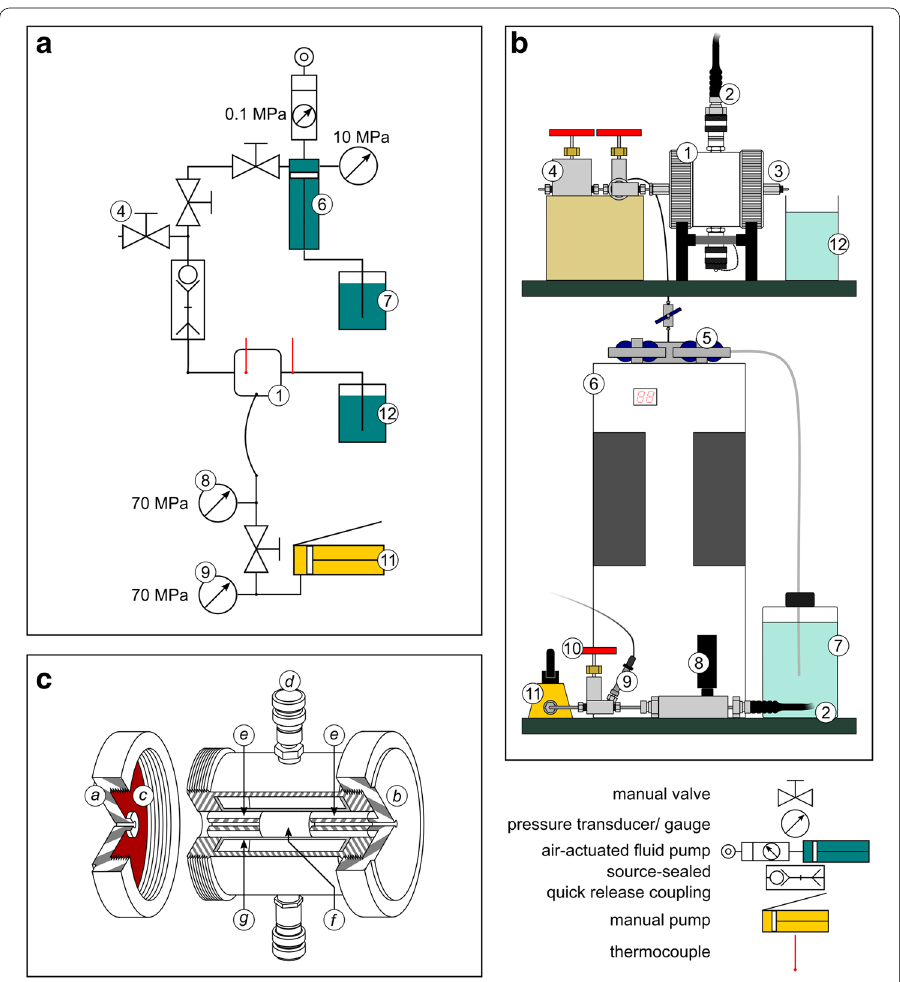
Fig. 4 Schematic of acid permeameter. a Technical diagram of permeameter circuit. b Sketch of primary components. c Diagram of pressure vessel interior. (1): pressure vessel; (2): confining pressure inlet/outlet; (3): pore fluid outlet; (4): vent valve; (5): pore fluid inlet/outlet ports; (6): Quizix pore fluid pump; (7): permeant reservoir; (8): pressure gauge; (9): analogue pressure transducer; (10): confining pressure outlet valve; (11): confining pressure pump/oil reservoir; (12): effluent reservoir. (a): upstream endcap; (b): downstream endcap; (c): silicone gasket; (d): confining pressure inlet/outlet; (e): steel spacers; (f): sample; (g): annular